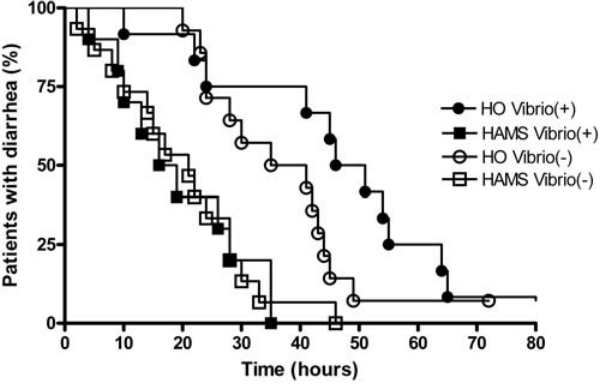
Figure 5. Recovery from diarrhea in patients with positive cultures for Vibriocholerae compared with those with negative cultures. Significant differences were noted between HAMS and HO ORS-treated patients in patients whose stool culture revealed Vibrio cholerae (log rank test, P , 0.001). Significant differences were noted between HAMS and HO ORS-treated patients also in the group of patients whose stool culture did not grow Vibrio cholerae (log rank test, P=0.006). The Vibrio -positive subgroup was not statistically significantly different from the group that was negative by culture, whether it was HAMS or HO-ORS, and the Vibrio -positive subgroup showed signifi- cantly quicker recovery when treated with HAMS.